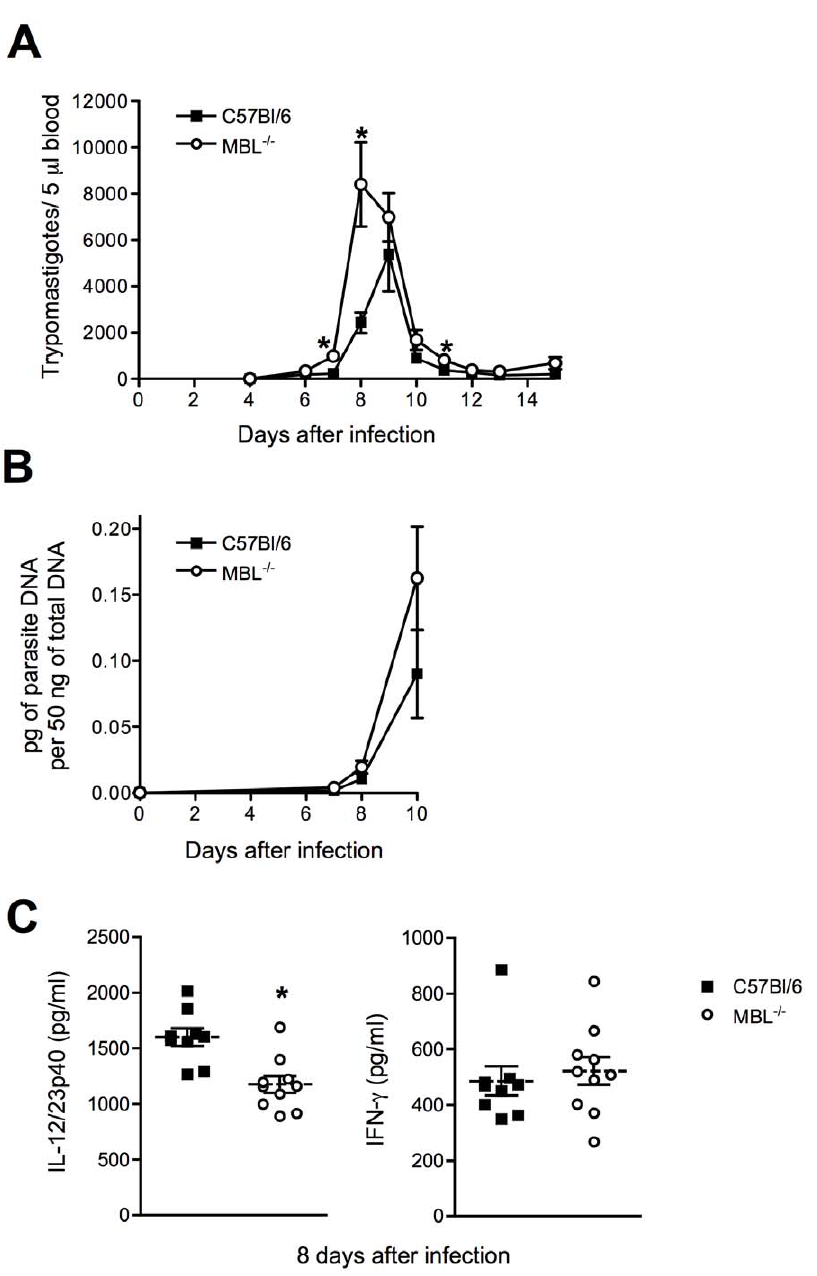
Figure 2. Role of MBL in host resistance to T.cruzi Y strain infection. WT or MBL 2 / 2 mice were infected with trypomastigotes of the reticulotropic, Y strain of T. cruzi and monitored daily for parasitemia and mortality (A). Symbols represent the mean of 10 animals per group. At the indicated time points after infection, levels of parasite DNA in the spleen were quantified by real-time PCR (B). Serum levels of IL-12/23p40 and IFN- c were determined by ELISA 8 days after infection (C). Each symbol in (B) and (C) corresponds to an individual animal, dashed lines the mean of each group and solid lines the standard error of the mean (SEM). The experiments shown are representative of at least two performed. *, Indicates statistically significant differences between